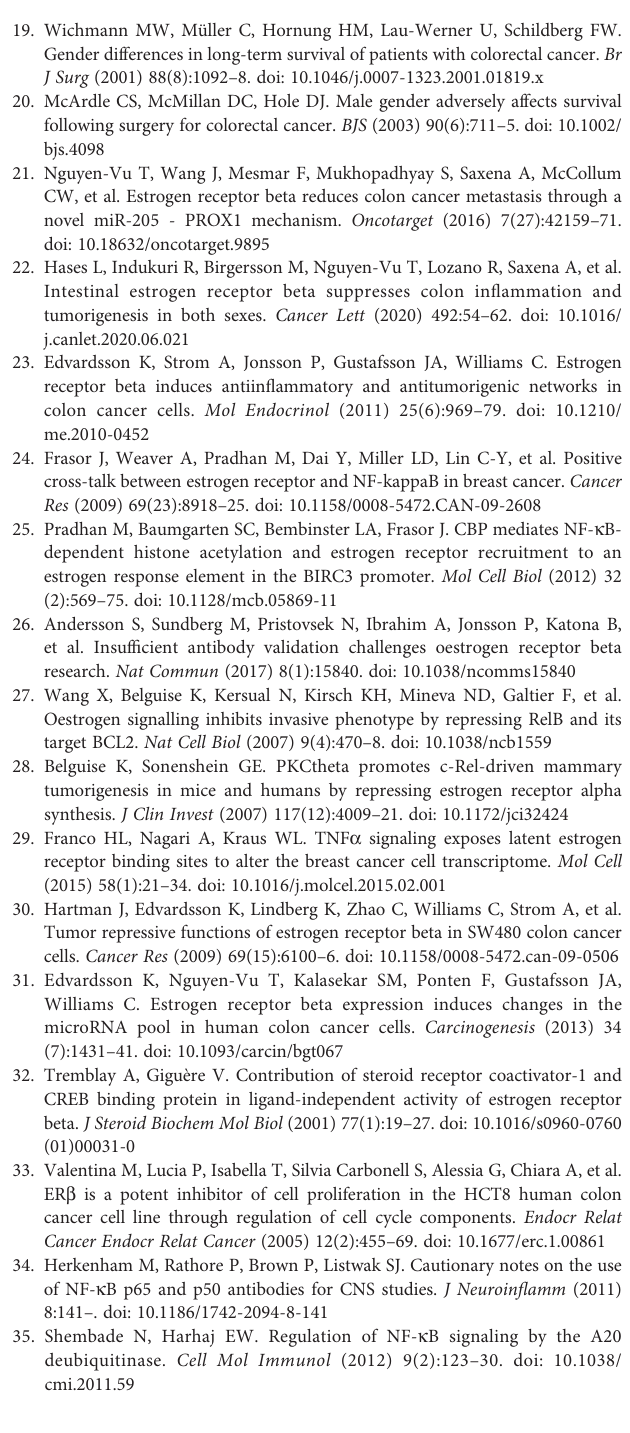
Supplementary Table 2 | p65 promoter binding sites in colon cancer cells. Supplementary Table 3 | p65-bound and TNF a -regulated genes in colon cancer